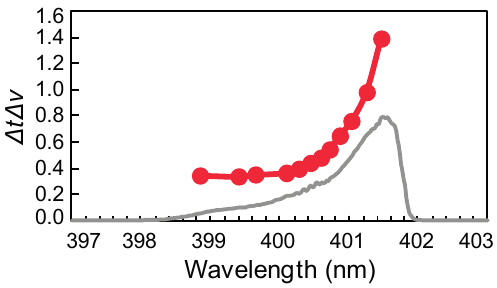
Figure 7. Time-bandwidth product of the optical pulses shown in Figure 6 as a function of the peak wavelength of the spectral components. Gray trace: the entire spectrum after the GaInN MLLD without the